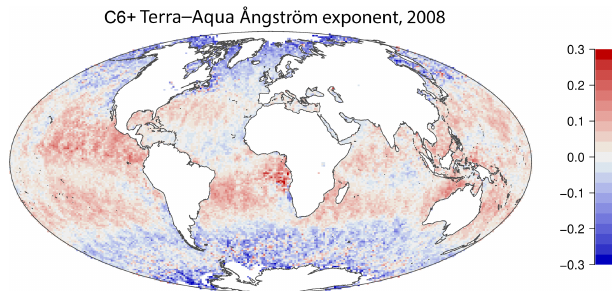
Figure 13. Impact of the C6 + corrections on the Terra–Aqua AE (0.55/0.86µm) differences during 2008. Compared to Fig. 4b, the overall global bias is